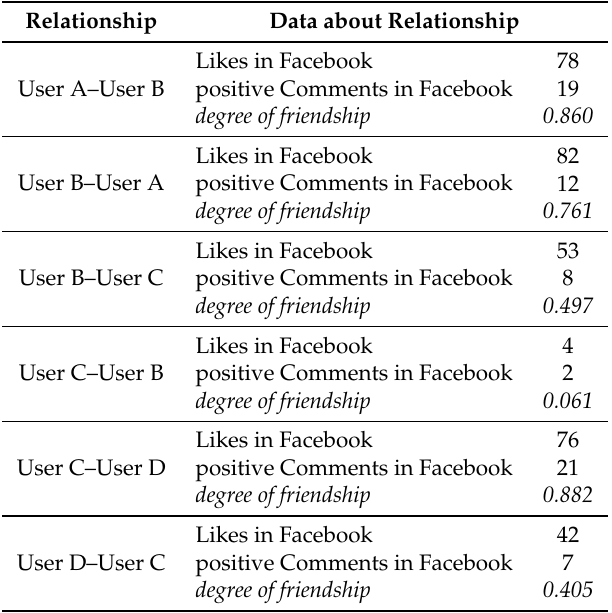
Table 4. Example of Degrees of Friendship.